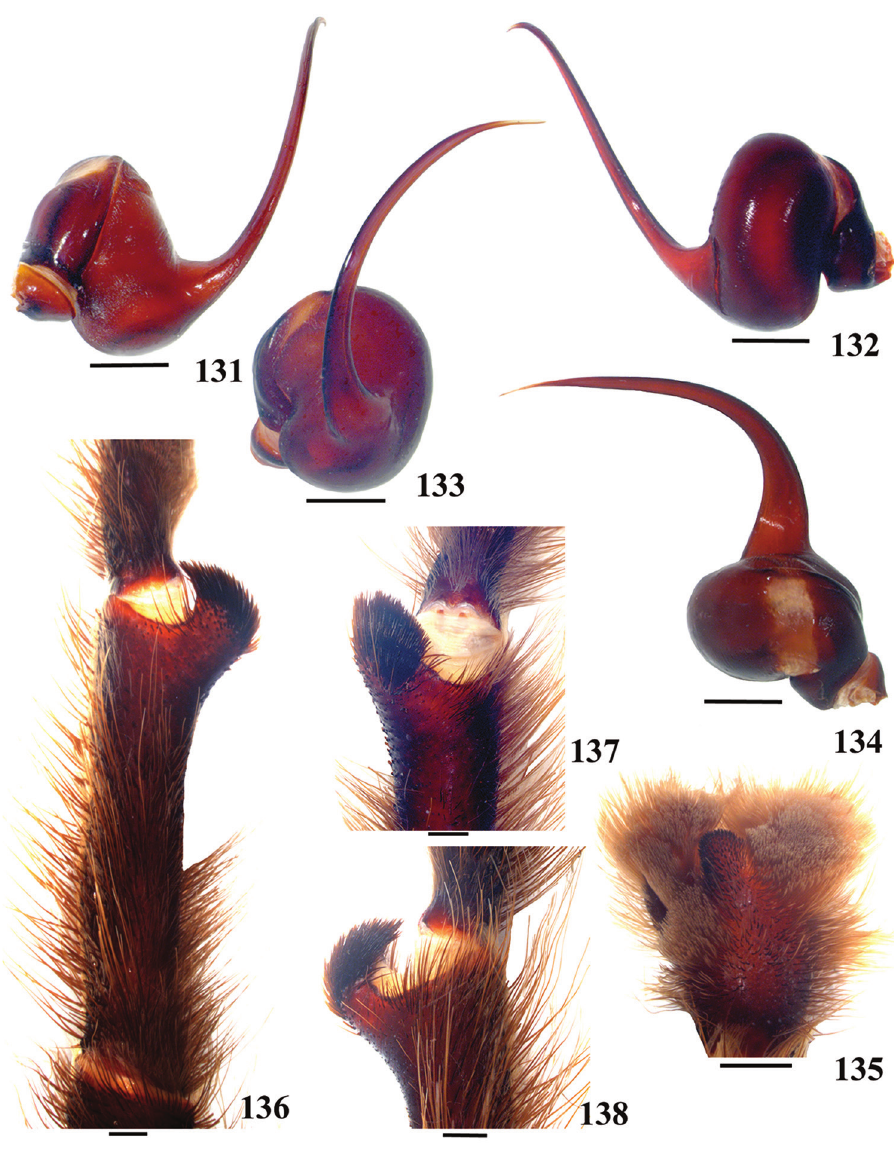
Figures 131–138. Avicularia rufa Schiapelli & Gerschman, 1945, male (MCP 13592). 131–134 right palpal bulb (mirrored) 131 prolateral 132 retrolateral 133 frontal 134 dorsal 135 right cymbium, dorsal (mirrored) 136–138 right tibial apophysis of leg I (mirrored) 136 prolateral 137 ventral 138 retrolateral. Scale bars = 1